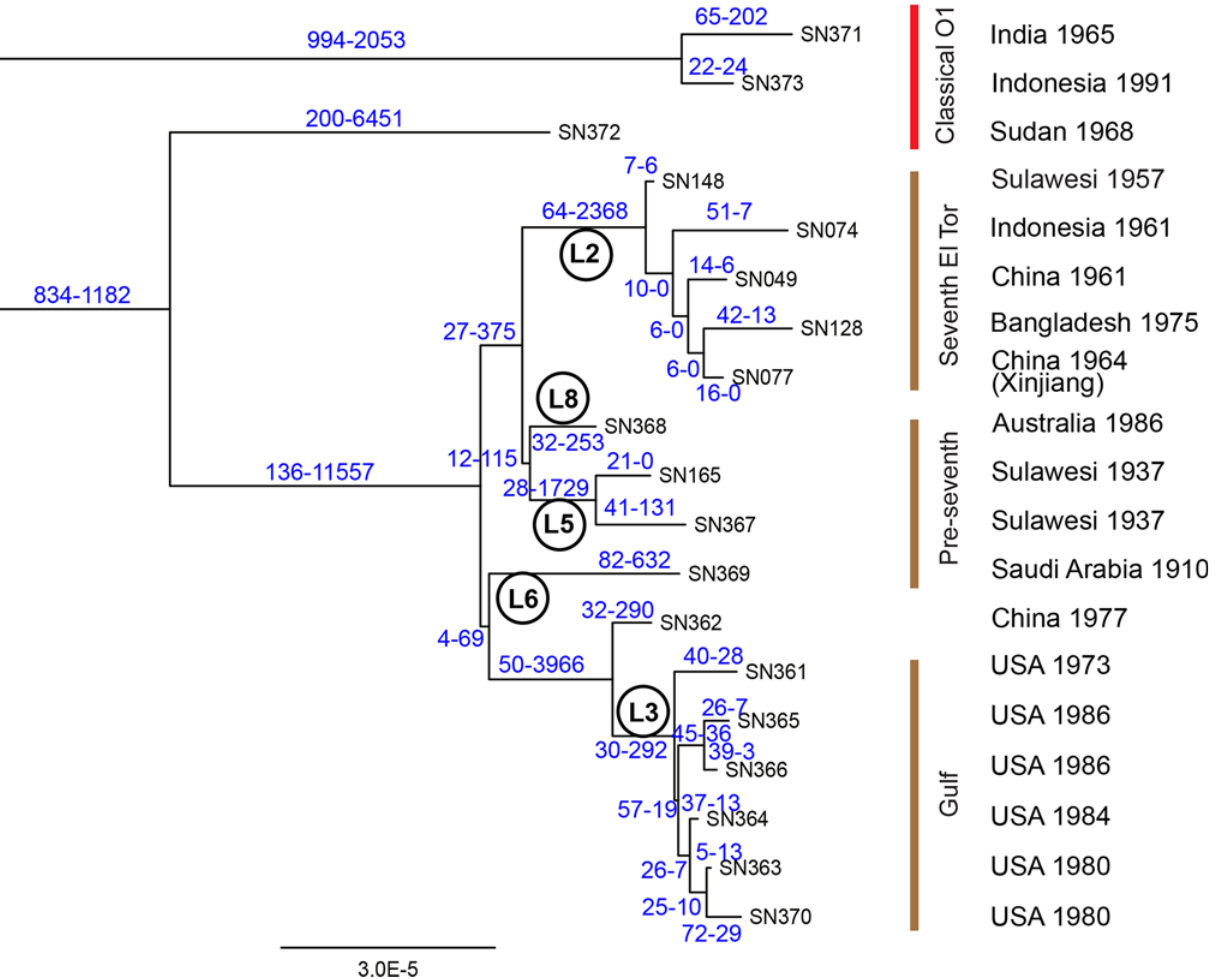
Fig 2. Phylogeny of 19 genomes from both El Tor and classical V . cholerae . The phylogeny is based exclusively on mutational SNPs (as identified using ClonalFrame), and the two numbers above each branch are the estimated numbers of SNPs caused by mutation and recombination, respectively. Lineage designations are indicated within circles. Strain designations (cf S1B Table) are indicated at the tips of the branches, and the source and date of isolation of each strain are shown at the right.